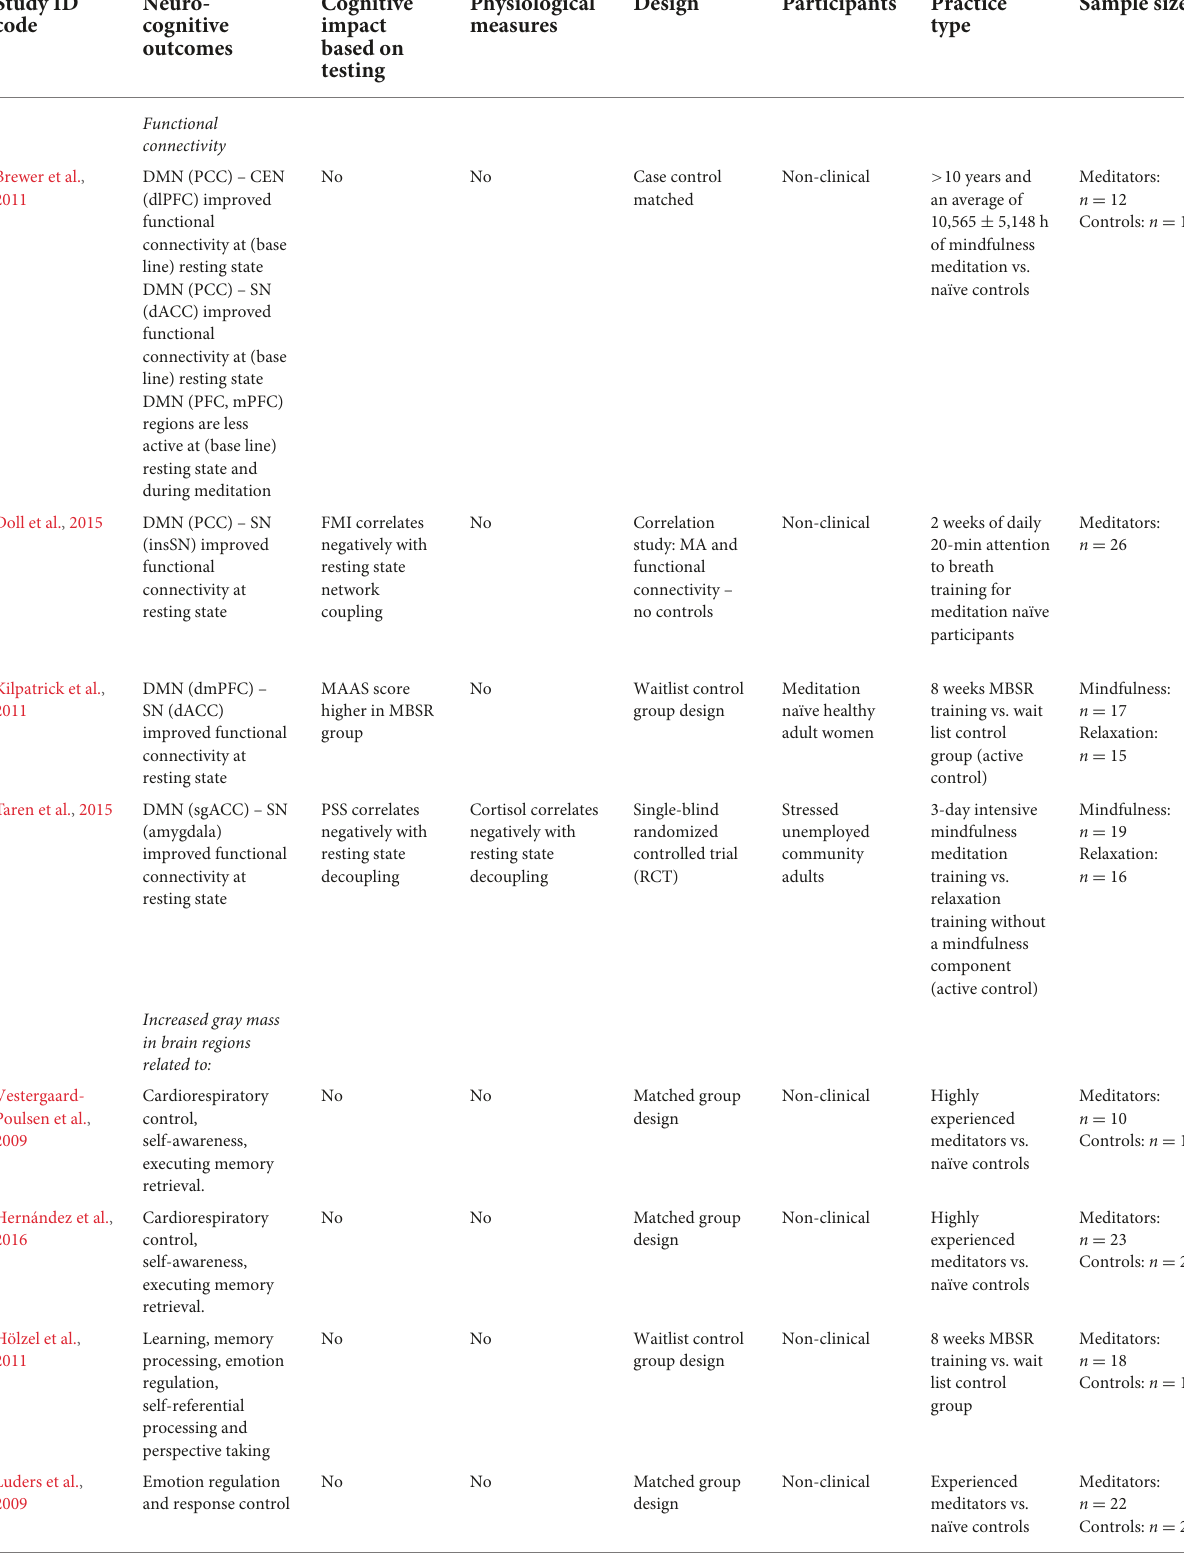
TABLE 2 Mindfulness meditation: experiential learning effects found and characteristics of included neurocognitive studies. Study ID